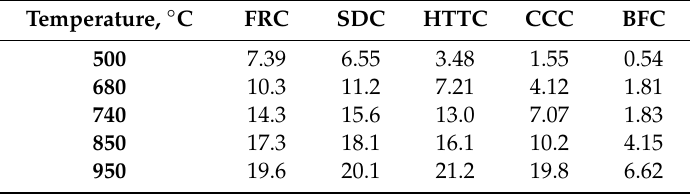
Table 8. Mass loss (wt %) of composites during interrupted tests.